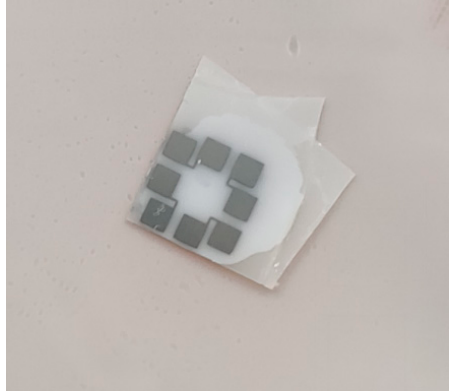
Figure 10. Adhesive double-sided samples.